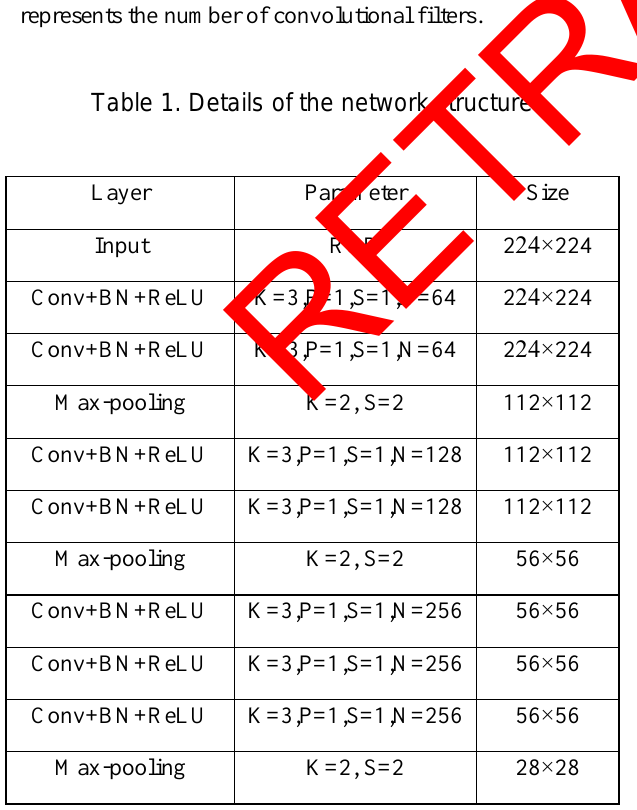
In order to achieve pixel-level building extraction from aerial images, this paper designs the network structure based on VGG-16 network. However, due to two factors, the full connection layer in VGG-16 is discarded. On the one hand, after discarding the full connection layer, the number of parameters to be learned is reduced from 138M to 14.7M, which reduces the network training pressure caused by too many learning parameters. On the other hand, it can preserve more spatial information in the feature map. Table 1 lists the network details used in this paper, where K represents the kernel size of the convolutional/deconvolution layer or pooling layer, P represents the size of the edge filling in the process of convolution, S represents the stride length, and N represents the number of convolutional filters.